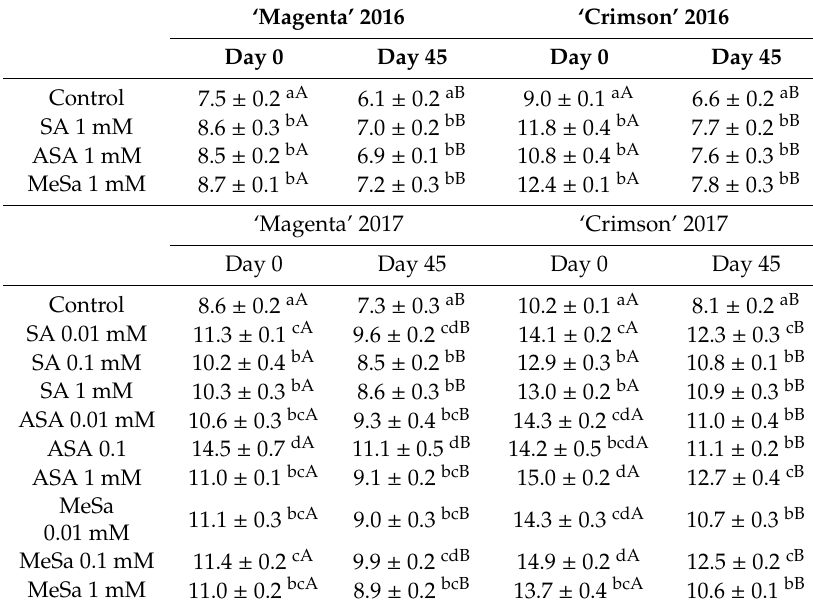
Table 3. Total acidity (g · kg − 1 ) at harvest (Day 0) and after 45 days of storage at 2 ◦ C (Day 45) in ‘Magenta’ and ‘Crimson’ table grapes as a ff ected by preharvest salicylic acid (SA), acetyl salicylic acid (ASA) and methyl salicylate (MeSa) treatments in 2016 and 2017